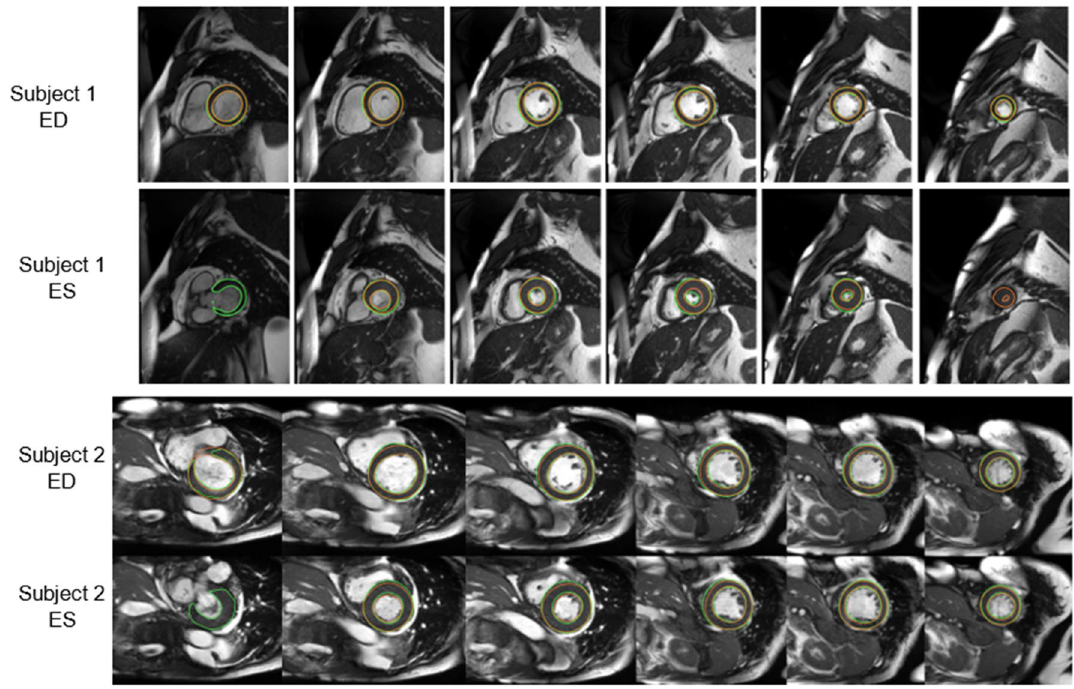
Figure 6. Examples EF prediction using the proposed methods compared to manual segmentation (green) and automatic segmentation (orange). Subject 1—top: Annotated EF = 66%; AutoSegmented EF = 76%; Predicted EF (proposed method) = 70%. Subject 2—bottom: Annotated EF = 32%; AutoSegmented EF = 42%; Predicted EF = 31%. Ground truth contours in green, Segmented contours in orange. Some slices are omitted (with similar contour